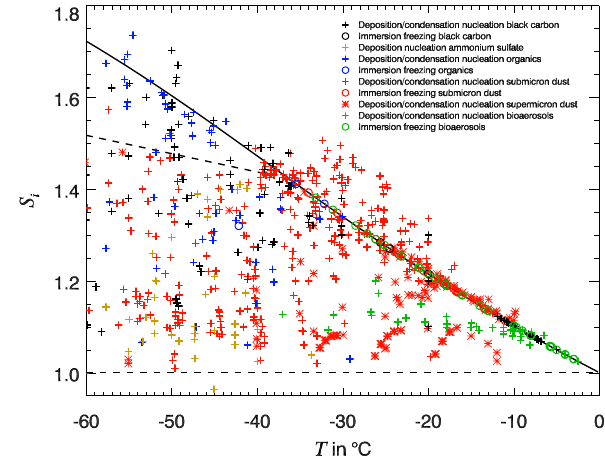
Fig. 1. Schematic representation of the different nucleation modes. specific composition (e.g., Pruppacher and Saenger, 1955;